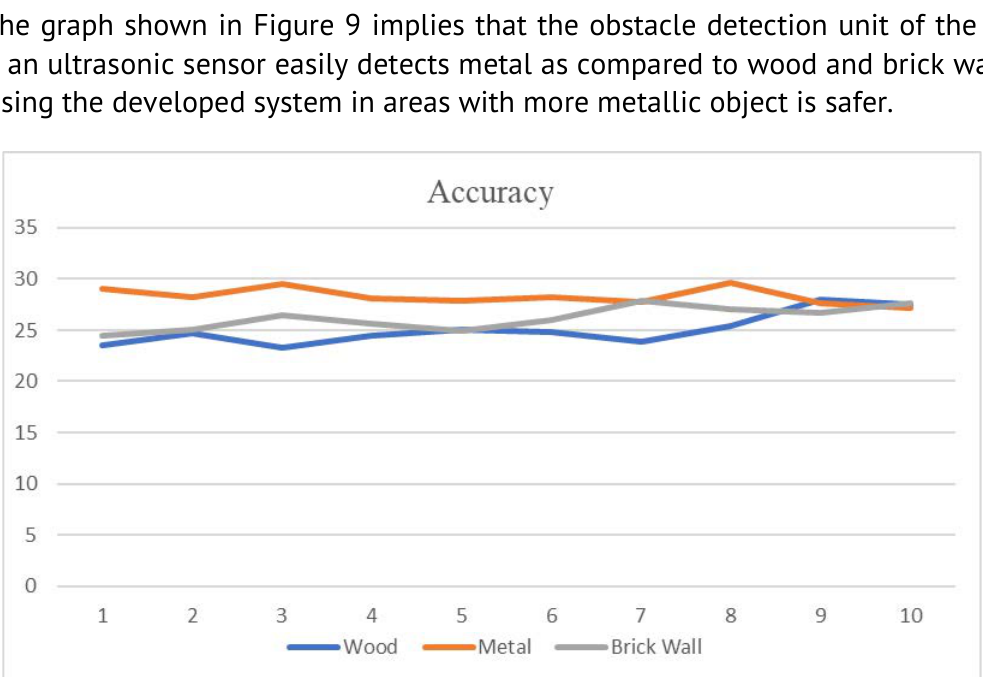
Figure 9. Graph comparing the accuracy of the obstacle detection unit with different